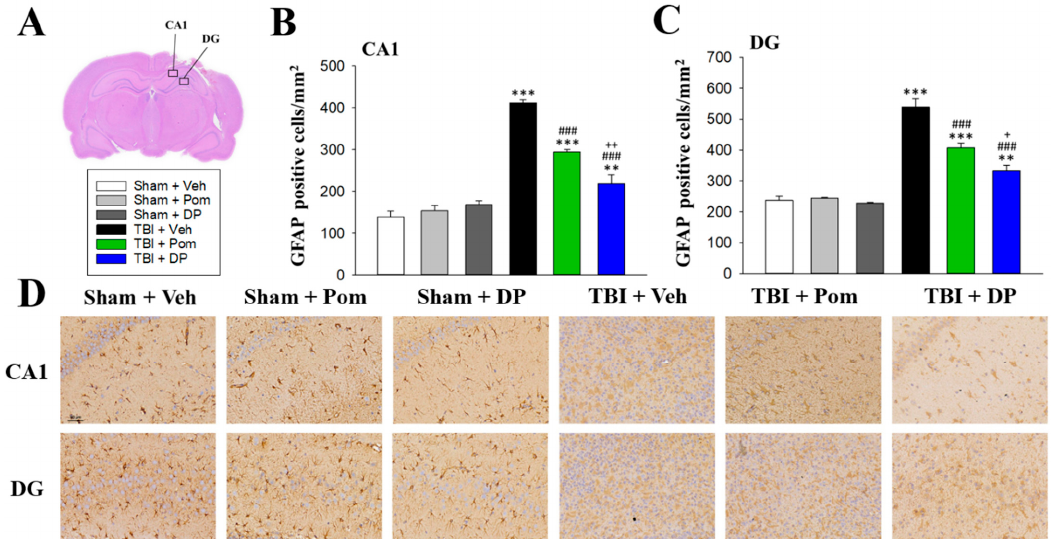
Figure 7. Post-injury administration of Pom or DP reduced TBI-induced astrogliosis in the hippocampus at 7 days after a TBI, with DP having better efficacy than Pom. ( A ) Representative image of an HE-stained coronal brain section from the TBI + Veh group that shows the areas of evaluation at 7 days after a TBI. Quantitative comparison of mean densities of GFAP positive cells in the hippocampal CA1 ( B ) and DG ( C ) regions at 7 days after a TBI. ( D ) Representative photomicrographs showing the GFAP-stained hippocampal CA1 and DG regions from various groups at 7 days after a TBI. Data are expressed as the mean ± S.E.M. ** p < 0.01, *** p < 0.001 versus Sham + Veh group; ### p < 0.001 versus TBI + Veh group; + p < 0.05, ++ p < 0.01 versus TBI + Pom group ( n = 5 in each group). Statistical differences were analyzed using independent sample t-tests and one-way ANOVA, followed by Tukey’s post hoc comparisons. Scale bar: 60 μ m.